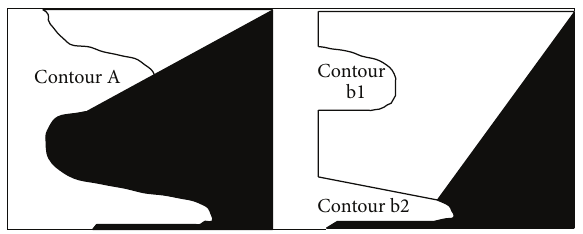
Figure 8: The continuous variety of the image